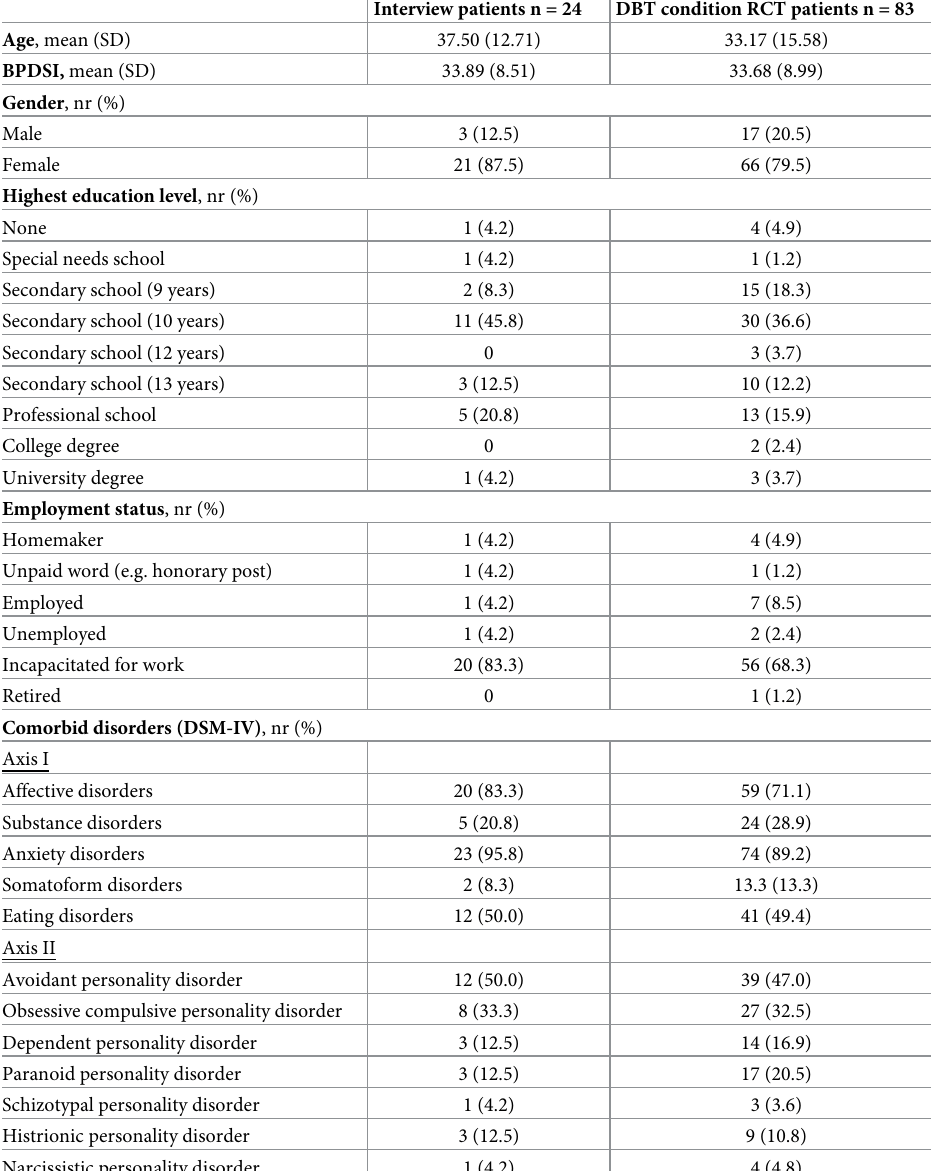
Table 2. Demographical and clinical characteristics of the interview patients and patients in the DBT condition of the RCT.